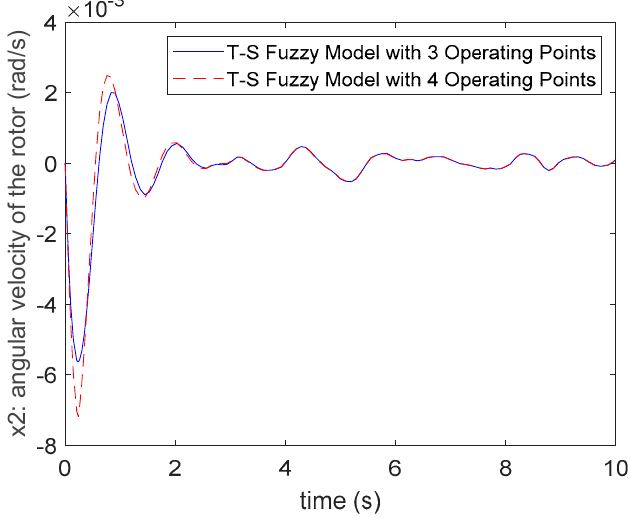
Figure 5. The comparisons of state ( )